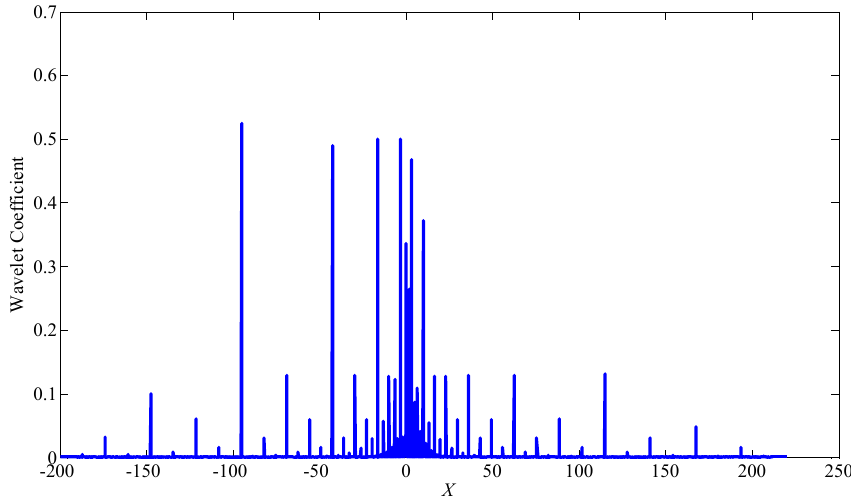
Figure 3. Wavelet transform coefficients of the Leland model’s solution (t = 0).